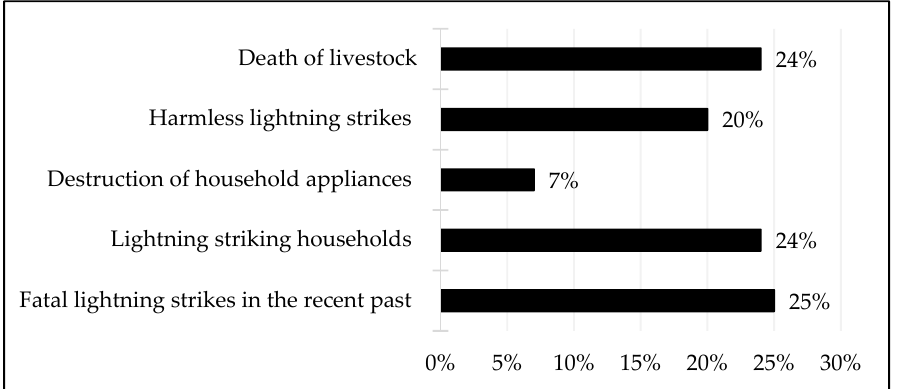
Figure 4. Experience of lightning strikes and their consequences.